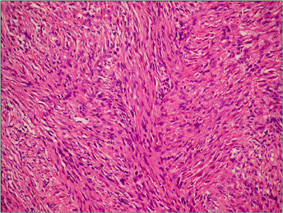
In microscopic appearance of histopathologic analyses, GIST cells   have paler eosinophilic cytoplasm with indistinct cell margins and minimal   tumor stroma  (H&E, W200).